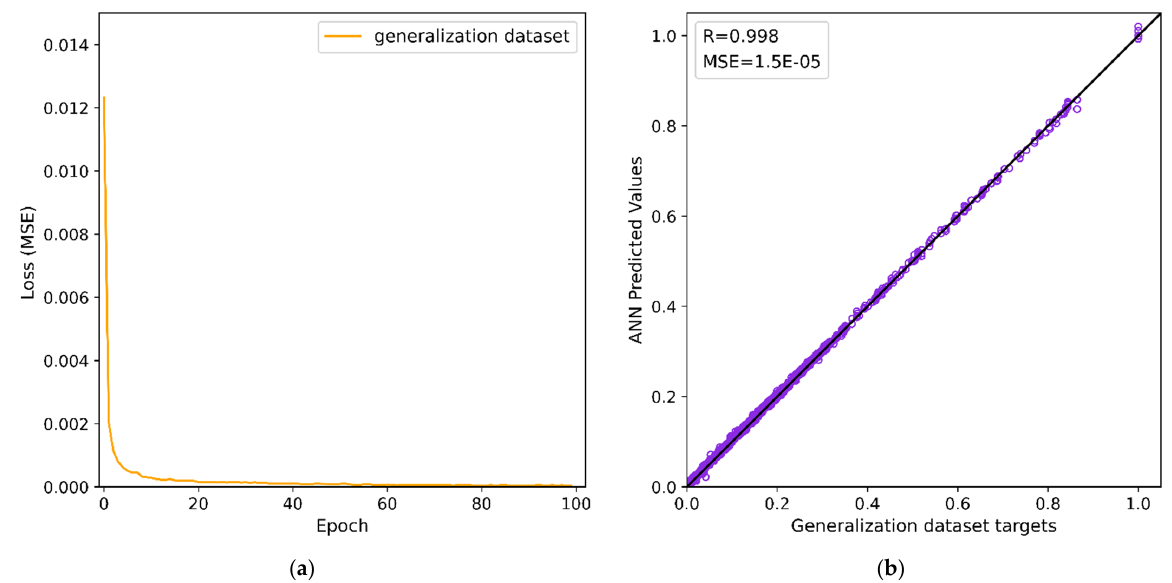
Figure 1. Error and performance metrics of the training procedure: ( a ) Evolution of the MSE during the training and validation of the generalization dataset ( b ) ANN predicted values against the respective targets of the generalization dataset.